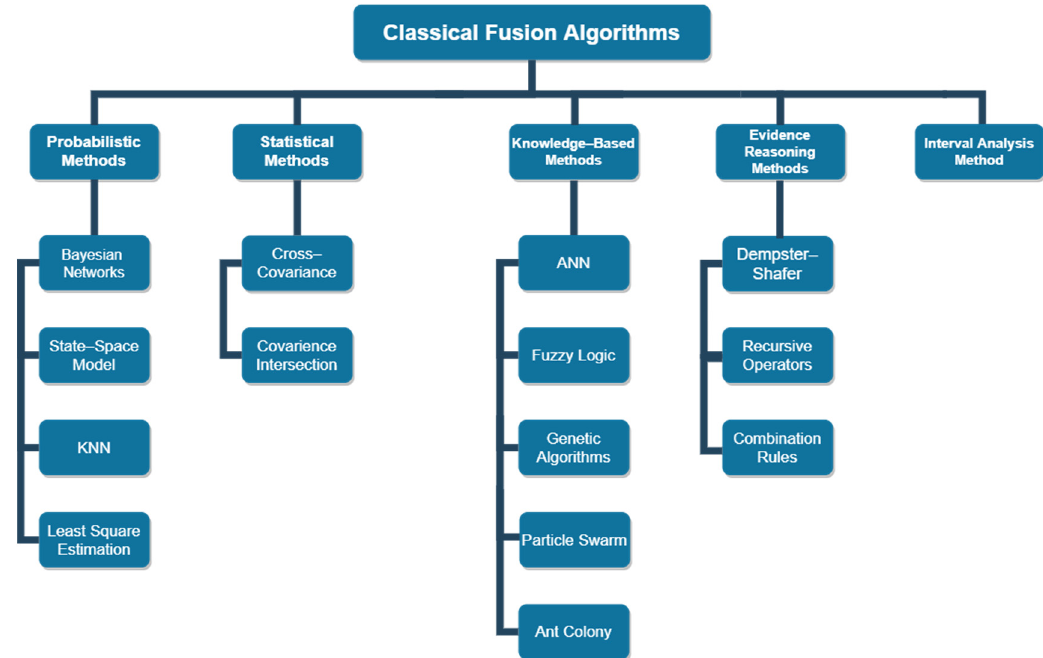
Figure 6. Classical approaches for sensor fusion algorithms. Table 2. A comparison between traditional sensor fusion algorithms, their advantages, disadvantages, applications, and fusion level.